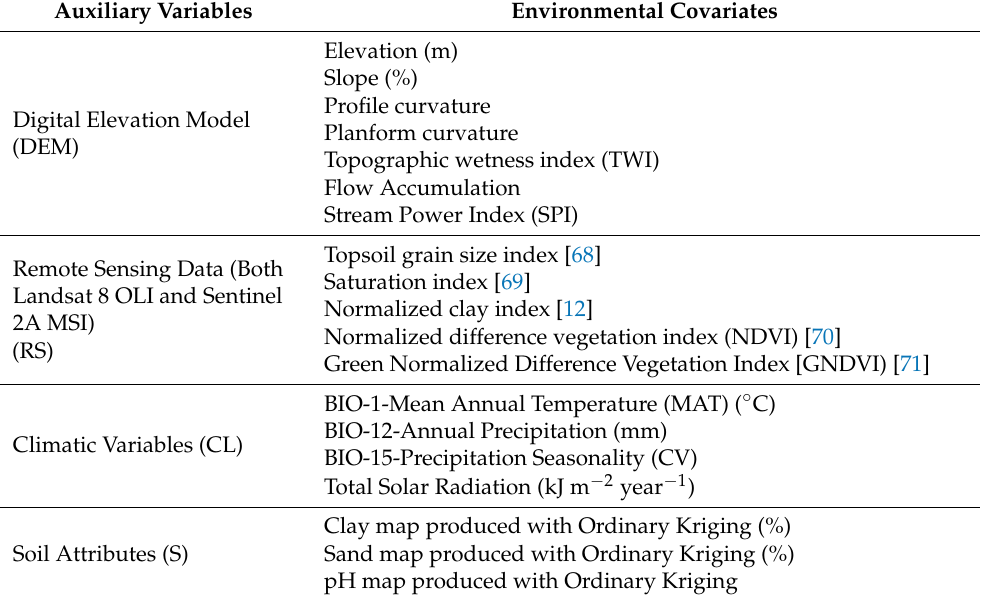
Table 2. Covariates used in this